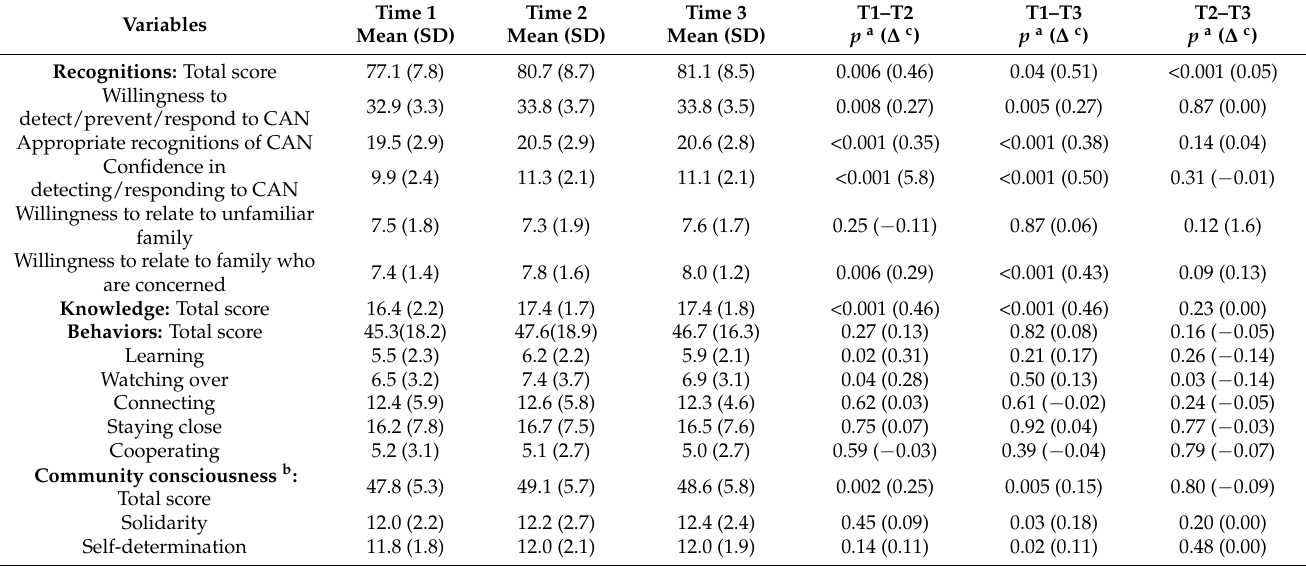
Table 2. Effects of TCAP-C ( n =